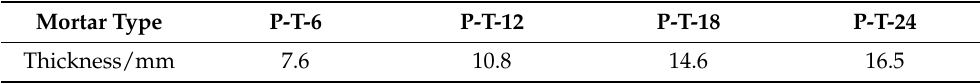
Figure 8. Epoxy resin filling in cracks. Table 3. Average filling depth of resin for